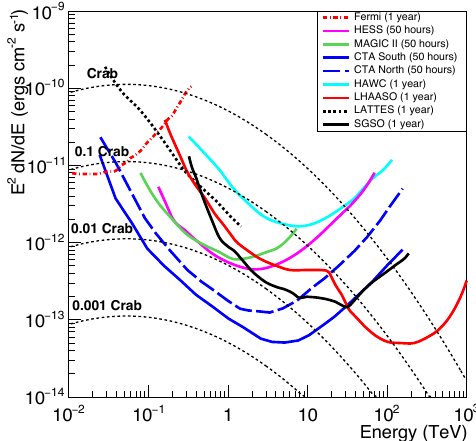
Figure 1. Di ff erential sensitivity (multiplied by E 2 ) to a Crab-like point gamma ray source of di ff erent exper- iments and projects. The best fit of the Crab Nebula data obtained by di ff erent detectors [17] is reported as a reference, extrapolated to 1 PeV